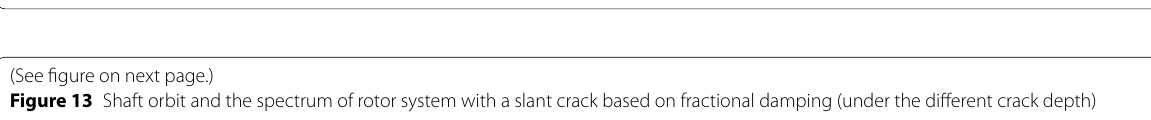
is 846 r/min, 1012 r/min, and 1528 r/min, respectively. From Figure 12, the shaft orbit is an internal 8-type shape. Under the rotating speed of 846 r/min, the first harmonic and second harmonic is the main compo- nents in the spectrum. In addition, the torsion frequency speed)(See figure on next page.) Figure 12 Shaft orbit and the spectrum of rotor system with a slant crack based on fractional damping (under the different rotating